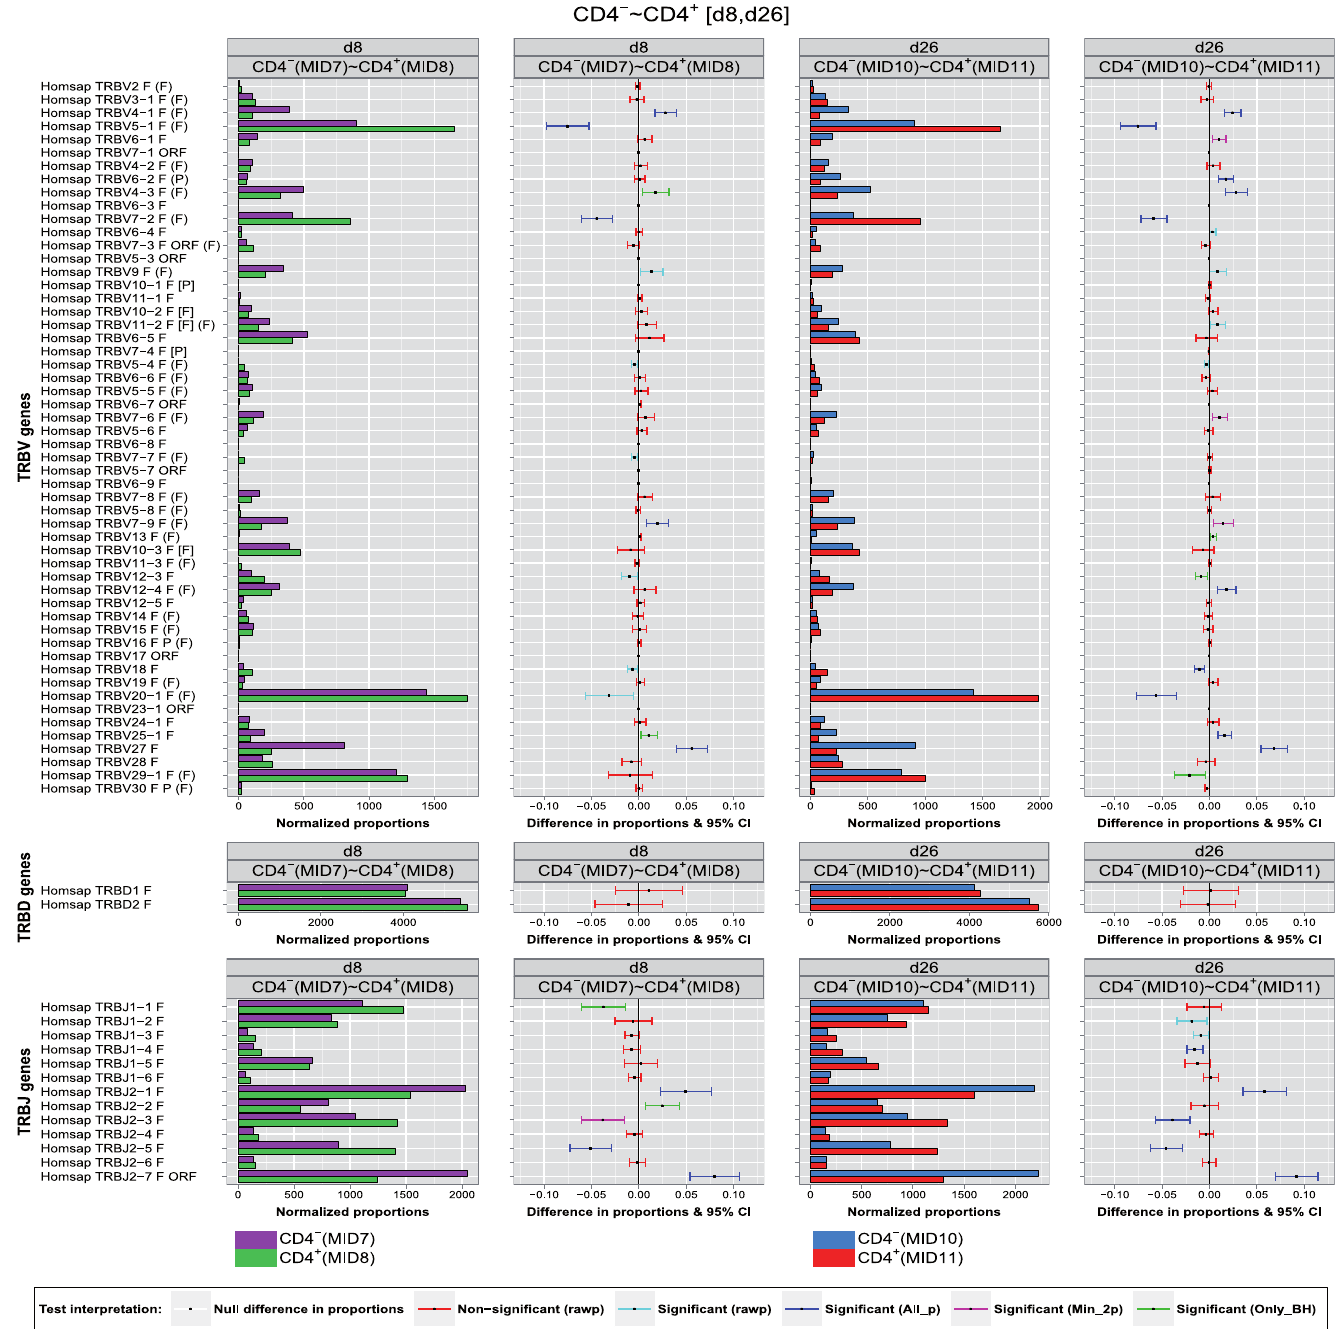
Fig 5. Synthesis graph (part 2: d8, d26). The synthesis graph is displayed for Homo sapiens TRB IMGT clonotypes (AA) with a gene of a given group (TRBV, TRBD or TRBJ) between two T cell populations (CD4 - and CD4 + ) at two time points (d8 and d26), with for each time point, two panels. Left panel: normalized bar graph (IMGT clonotypes (AA) proportions normalized for 10,000 IMGT clonotypes (AA) per group), with juxtaposed colored bars corresponding to CD4 - (top) and CD4 + (bottom). Right panel: difference in proportions graph with significance and confidence interval (CI) bars. CI bar colors correspond to the test interpretation before adjustment of p -values (rawp) (non-significant: red, significant: light blue) and after adjustment by the multiple testing procedures (significant differences validated by the seven procedures (All_p): dark blue, by two or more multiple testing procedures (Min_2p): pink, and only by BH (Only_BH):